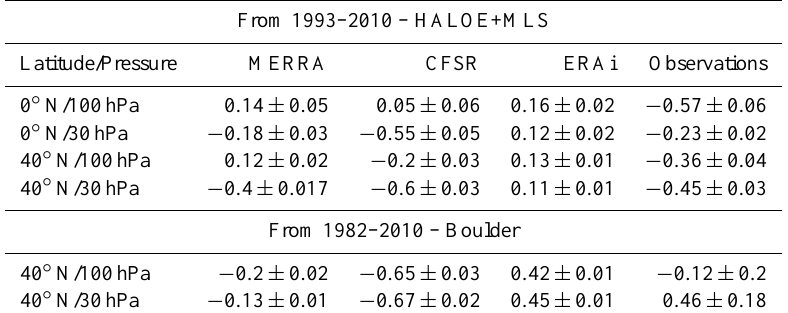
Table 2. Net change in water vapor from models and observations inppmv over indicated period From 1993–2010 – HALOE+MLS Latitude/Pressure MERRA CFSR ERAi